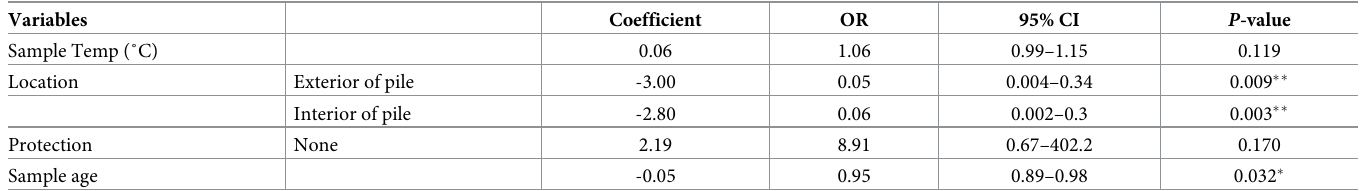
Logistic regression analysis was performed to predict the likelihood of Salmonella to be isolated from poultry litter samples.